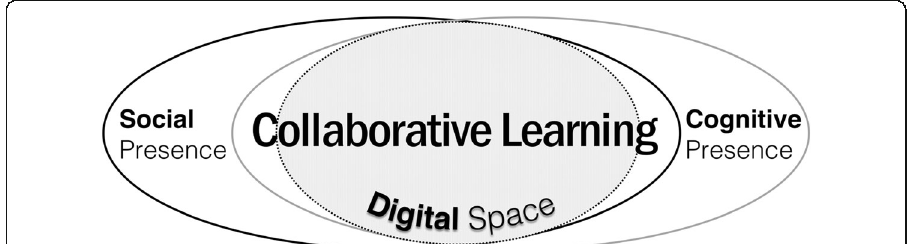
Fig. 1 The Fully Online Learning Community Model. The synergistic dimensions of the Fully Online Learning Community (FOLC) model are conceptualized as Social Presence (SP) and Cognitive Presence (CP) occurring primarily within a Digital Space comprised of community-selected, asynchronous and synchronous affordances. Successful Collaborative Learning occurs at the intersection of these dimensions as the learners develop their sense of community and requisite digital competencies are applied to support critical inquiry. Recognizing that not all social and cognitive interactions are digitally mediated, even in fully online courses/programs, FOLC may be adapted to hybrid-learning environments by strategically resizing/repositioning the Digital Space in relation to SP and